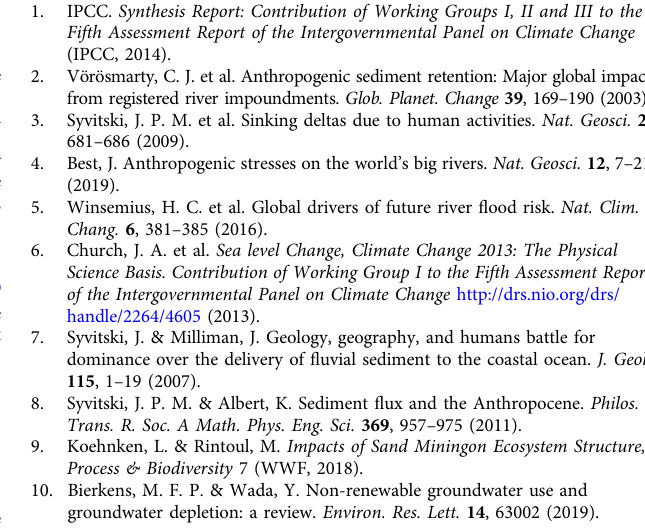
Fig. 8 The Tonle Sap Lake hydrological cycle. Discharge division diagram showing contributions from the Tonle Sap Lake and Mekong River entering the Mekong Delta in the two channels of Tan Chau and Chau Doc.